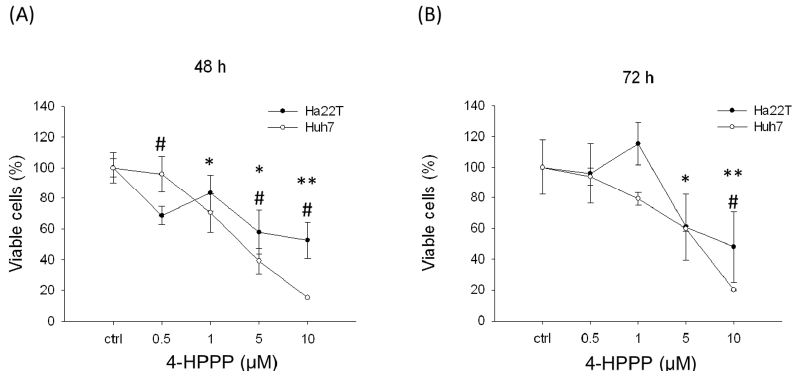
Figure 1. The inhibitory effect of 4-HPPP on the short-term proliferation of HCC cells. Two HCC cells. Huh7 and Ha22T were seeded on a 12-well plate and treated with indicated concentrations (from 0.5 to 10 µ M) of 4-HPPP for 48 h ( A ) and 72 h ( B ) respectively. Ctrl: Vehicle as a control group. * p < 0.05